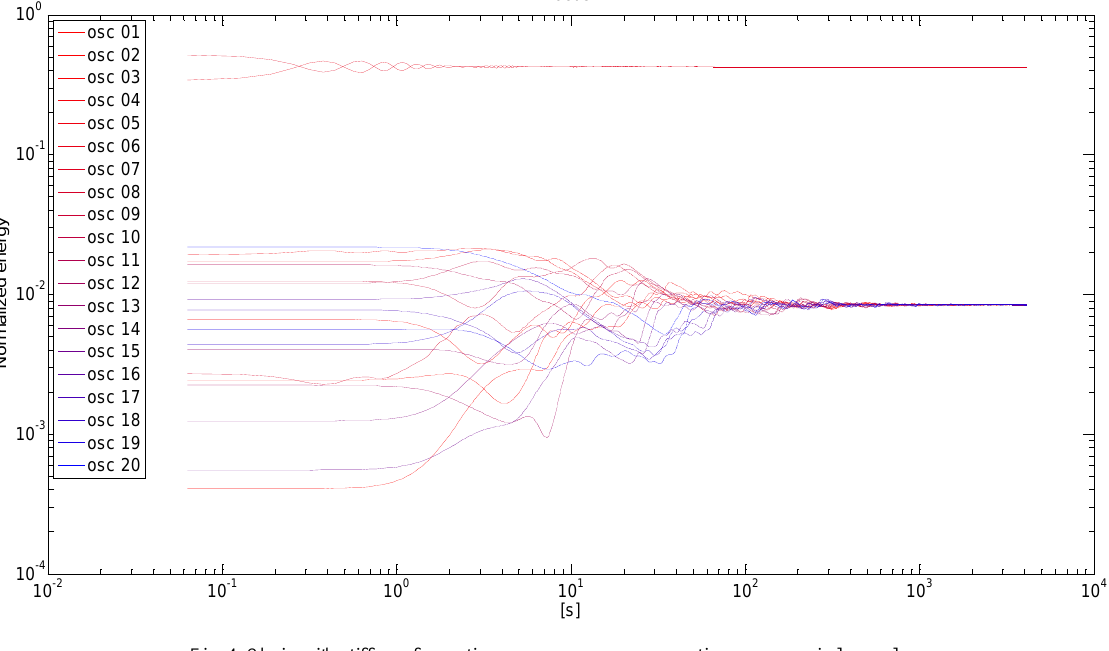
Fig. 4. Chain with stiffness focus, time energy averages versus time, x, y axes in log scale.